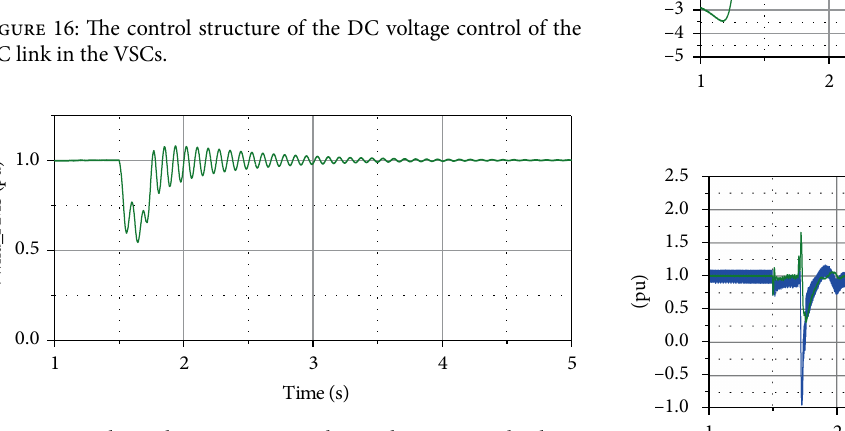
Figure 17: Voltage characteristics on the machine terminal voltage of the wind farm.